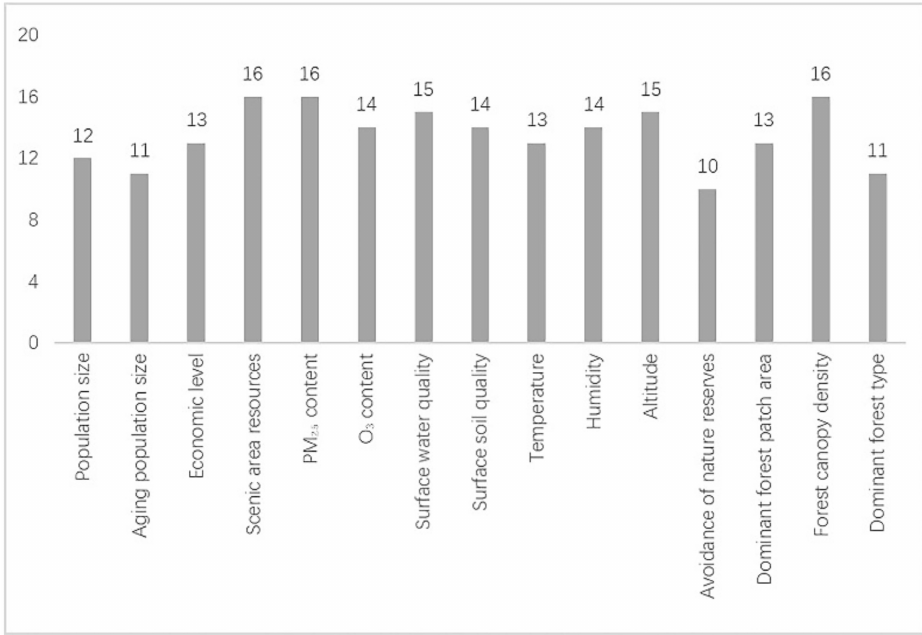
Figure 1. The frequency distribution diagram of FHB evaluation standards according to existing